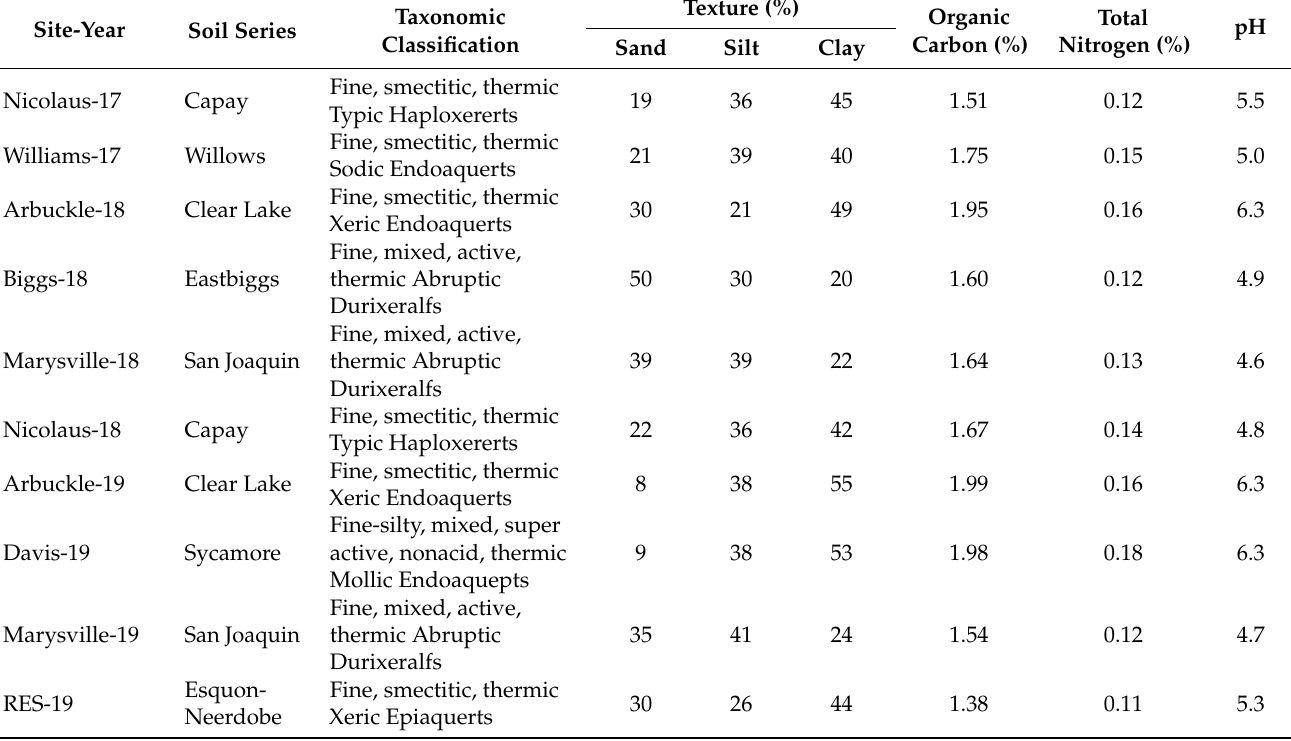
Table 1. Soil descriptions and selected properties of each N response trial site-year located throughout the Sacramento Valley,